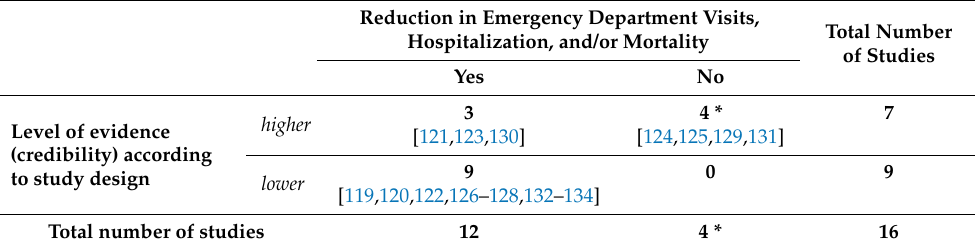
Table 4. Reduction in emergency department visits, hospitalization and/or mortality and level of evidence of the study